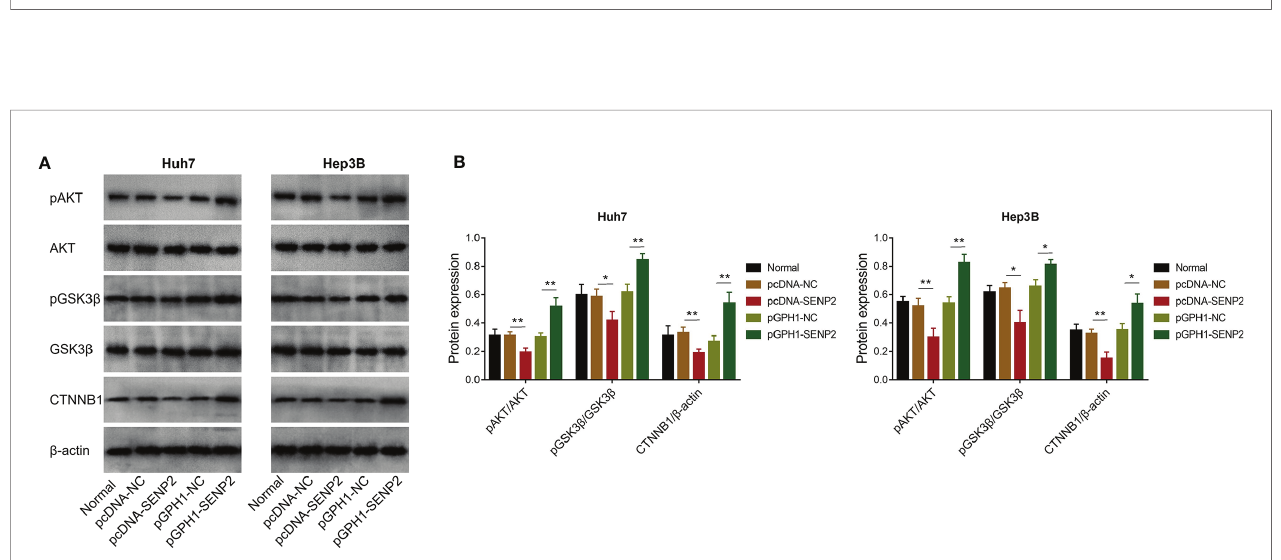
FIGURE 4 | AKT/GSK3 b /CTNNB1 pathway after plasmid transfection. Detection of protein expressions by Western blot in Huh7 and Hep3B cells after transfection (A) . Comparison of pAKT/AKT, pGSK3 b /GSK3 b , and CTNNB1 expressions among groups in Huh7 and Hep3B cells after transfection (B) . SENP2, Small ubiquitin- like modi fi er speci fi c peptidase 2; NC, negative control; AKT, protein kinase B; GSK3 b , glycogen synthase kinase-3 b ; CTNNB1, b -catenin; * p < 0.05; ** p <